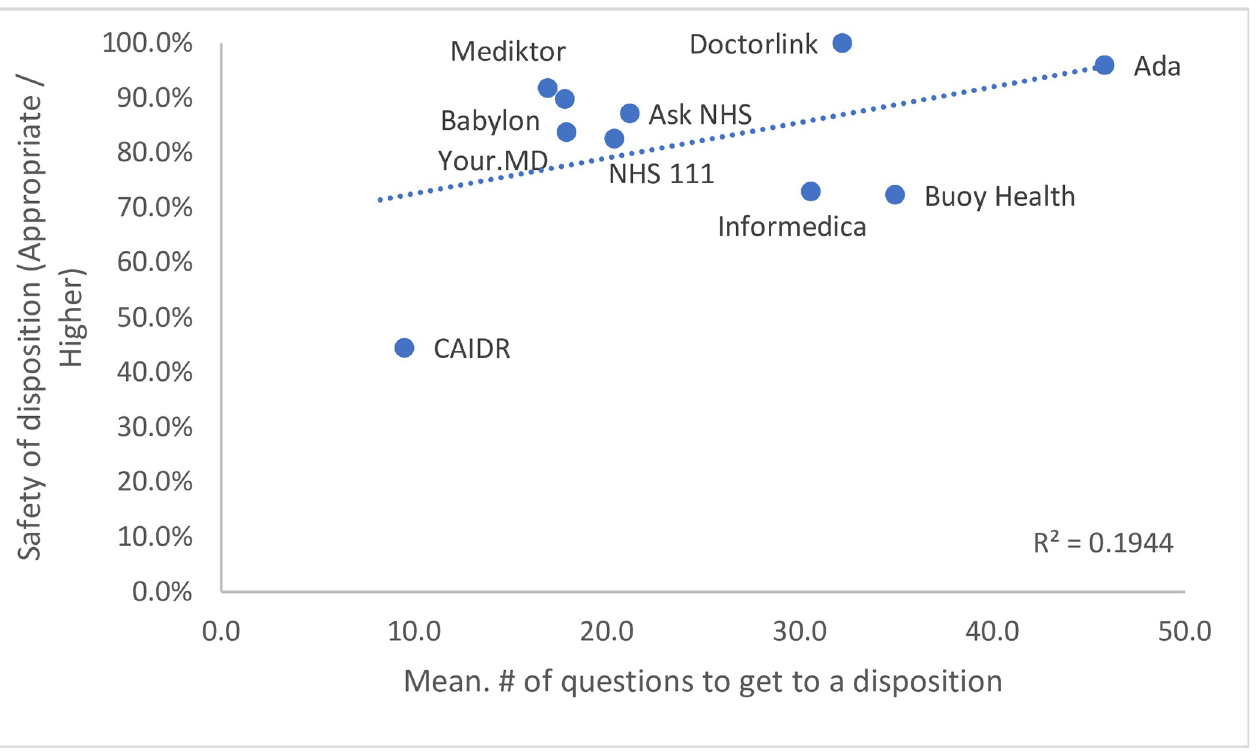
Fig 4. Correlation of mean number of questions to triage